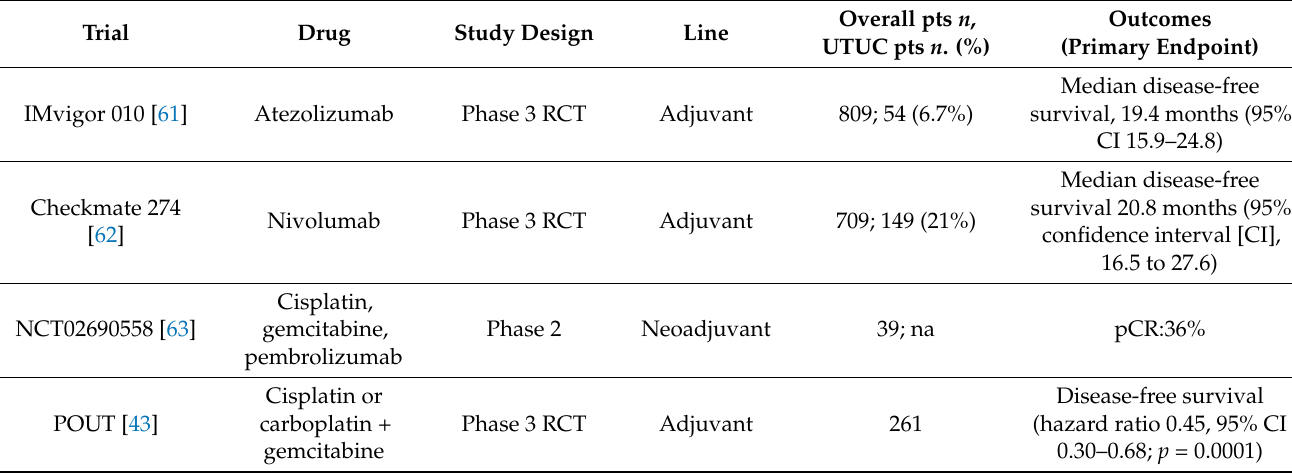
Table 1. Adjuvant and neoadjuvant systemic treatment for UTUC